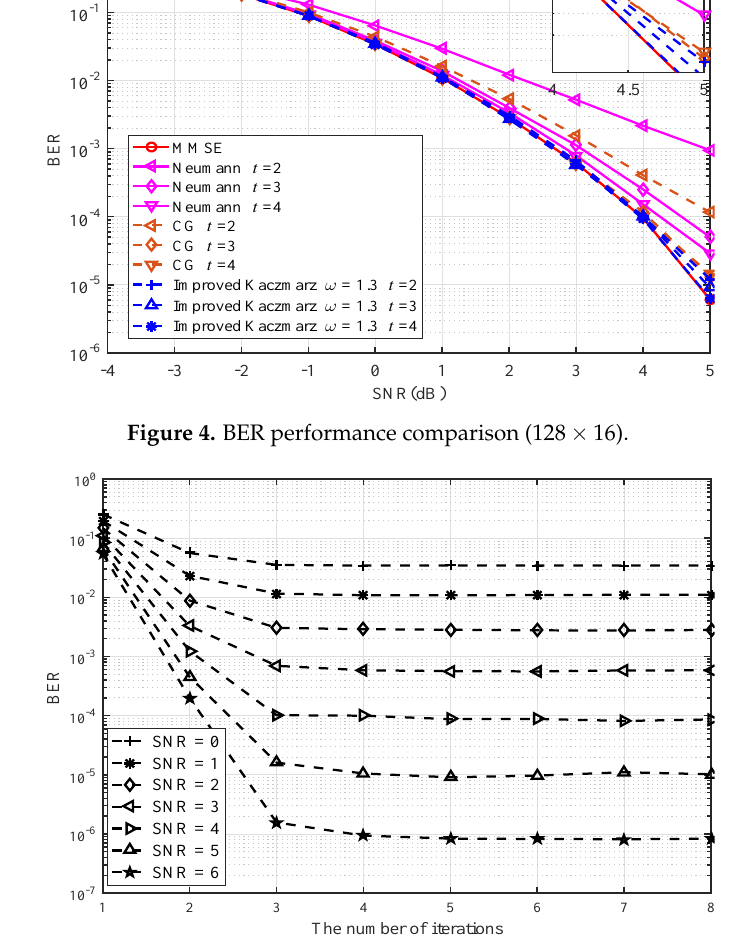
and t = 4. For different SNR, the optimal relaxation parameter ω opt is found to exist between 1.2 and 1.35. It is shown to be independent of the SNR and can be set as a